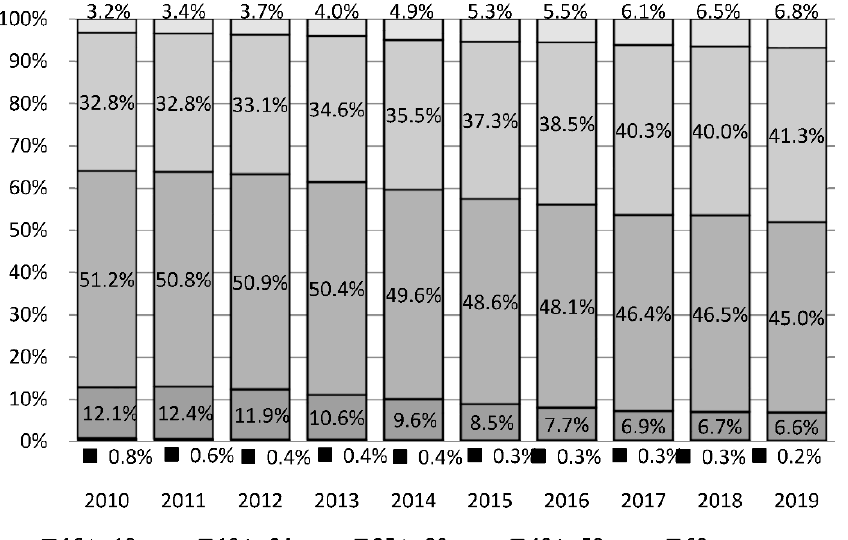
Figure 2. Prisoners in Portuguese prison establishments by age (2010–2019). Source: own elaboration, based in DGPJ 2020.